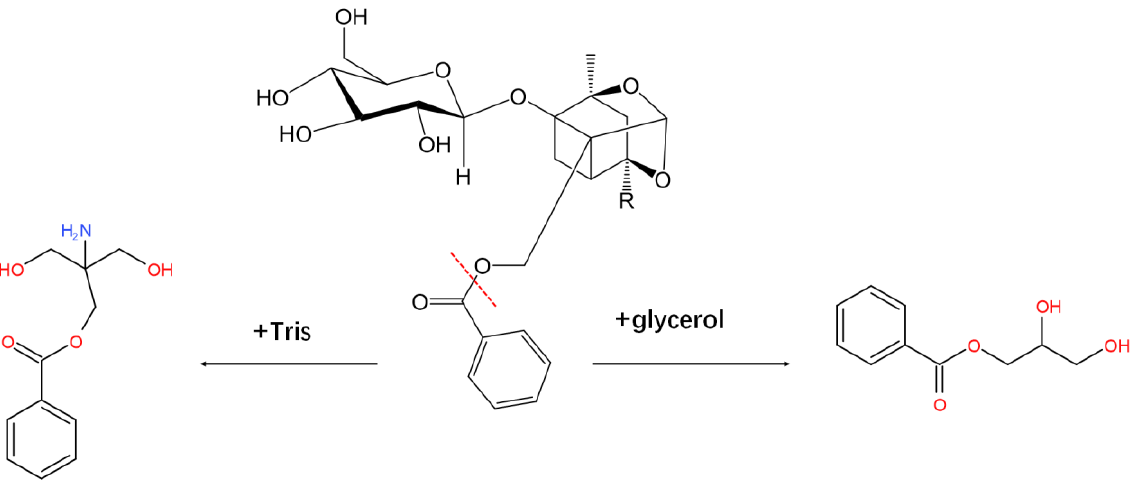
Figure 13. The structure analysis of the product formation process. The benzoic acid group was enzymatically hydrolyzed by G6046. The cleaved benzoate reacted with either Tris or glycerol presented in the experimental buffer to produce P2 and P3.